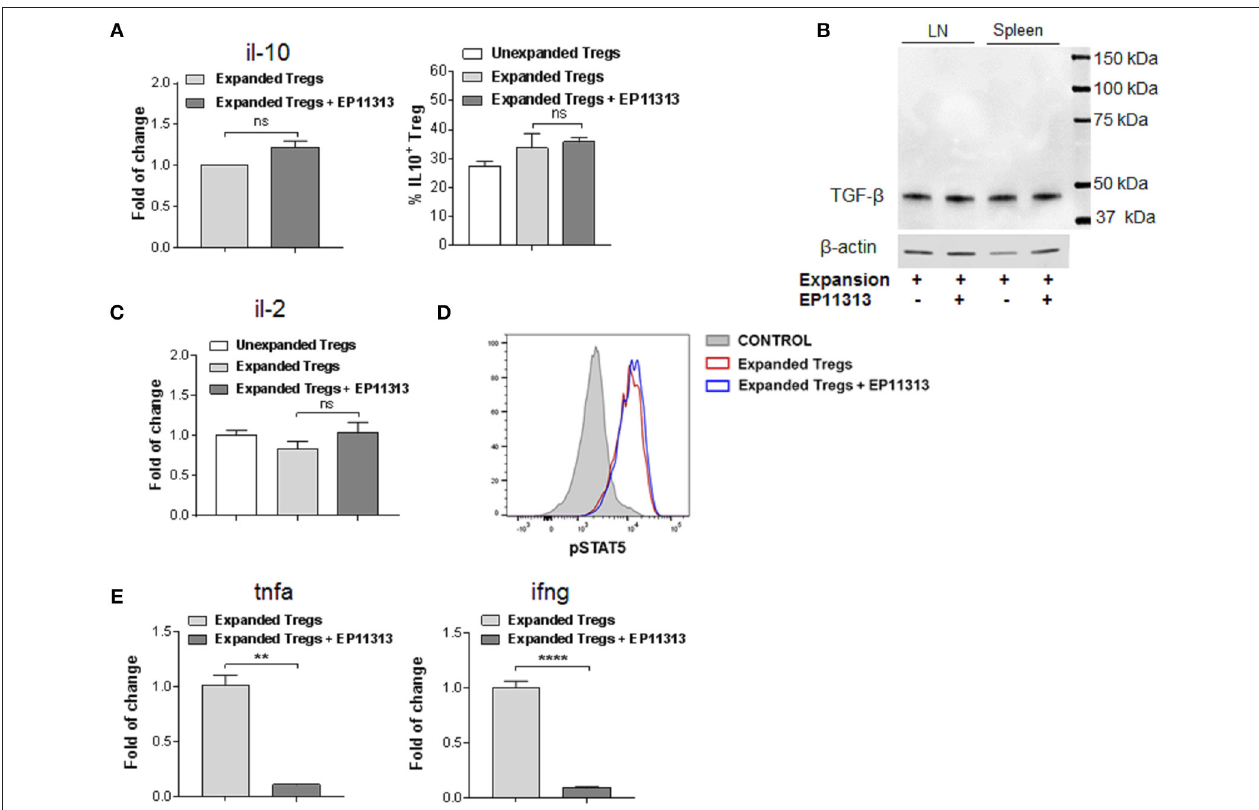
FIGURE 4 | EP11313 regulates inflammatory cytokines but spares the IL-2 pathway and Treg effector molecules. Tregs were expanded with TL1A-Ig + IL-2 in the presence or absence of EP11313 10 mg/kg, mice were sacrificed at day 7 and splenic Tregs (CD4 + FoxP3 + ) and non-Tregs (CD4 + FoxP3 − and CD4 − FoxP3 − ) were isolated by FACS (A–E) . Quantitative Real-time PCR (qPCR) analysis of il-10 mRNA levels (relative to gapdh) of splenic CD4 + Foxp3 + Tregs sorted from expanded ± EP11313 mice (left). Data are pooled from two independent experiments. IL-10 production by CD4 + FoxP3 + Tregs from LN of expanded and expanded + EP11313 mice after phorbol 12-myristate 13-acetate (1ng/mL) + ionomycin (1 µ M) stimulation for 6h in the presence of monensin (right) (A) . Western Blot analysis of TGF- β levels in sorted Tregs from LN and spleen of mice treated in vivo with TL1A-Ig + low dose IL-2 in the presence or absence of EP11313. β -actin was used as a loading control (B) . qPCR analysis of il-2 mRNA levels (relative to gapdh) of splenic non-Treg population sorted from unexpanded, expanded or expanded + EP11313 treated mice (C) . Representative pSTAT5 staining shown by flow cytometry in CD4 + FoxP3 + Tregs from peripheral blood of expanded ± EP11313 treated B6-FoxP3